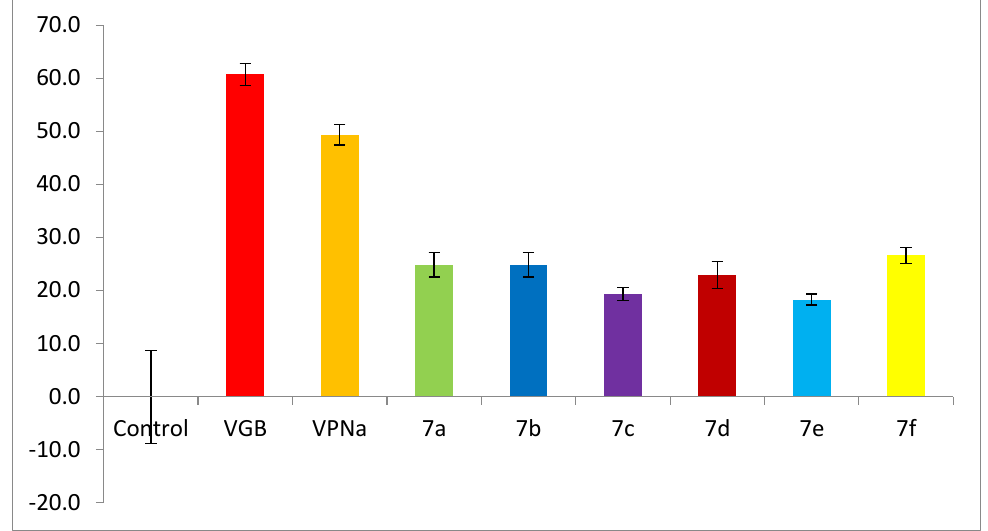
Figure 3. GABA-AT % enzymatic activity of compounds 7a – f as compared to VGB and VPNa.